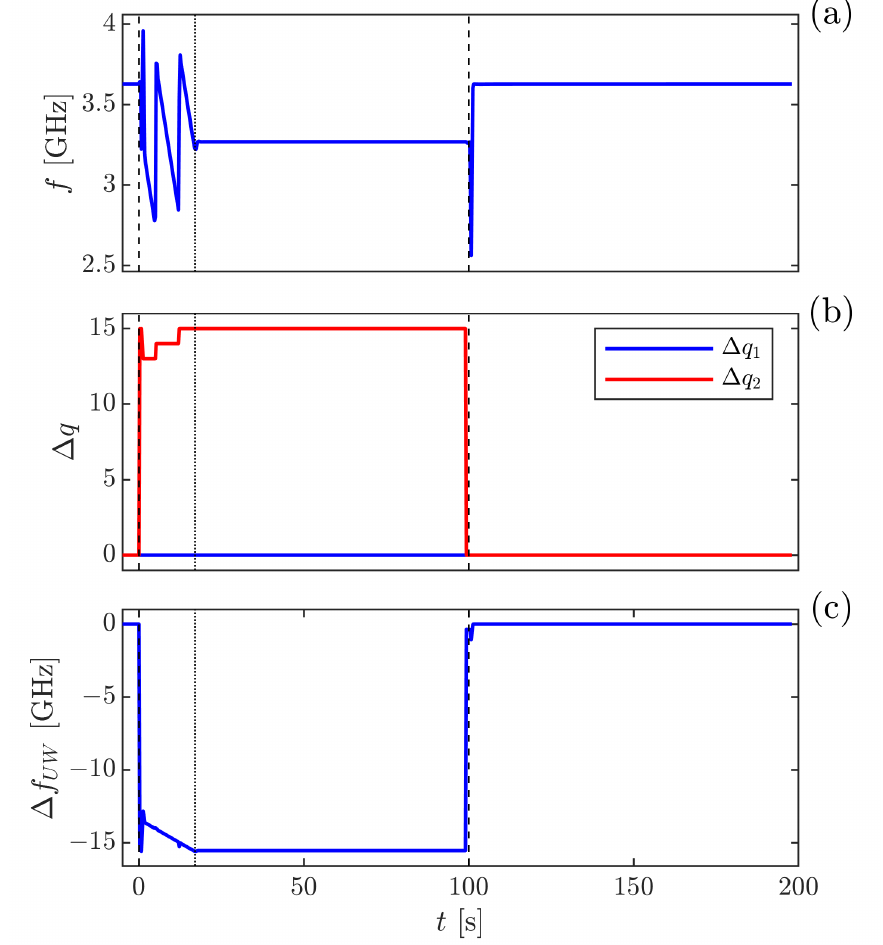
Figure 5. The time evolution of ( a ) the raw beat frequency [ f ( t ) ]; ( b ) the evaluated shift in mode number ( ∆ q 1 ( t ) and ∆ q 2 ( t ) ); and ( c ) the corresponding unwrapped beat frequency ( f UW ( t ) ) from the SOP over a 200 s long modulation cycle. For descriptions of the various time intervals of the modulation cycle, see the caption of Figure